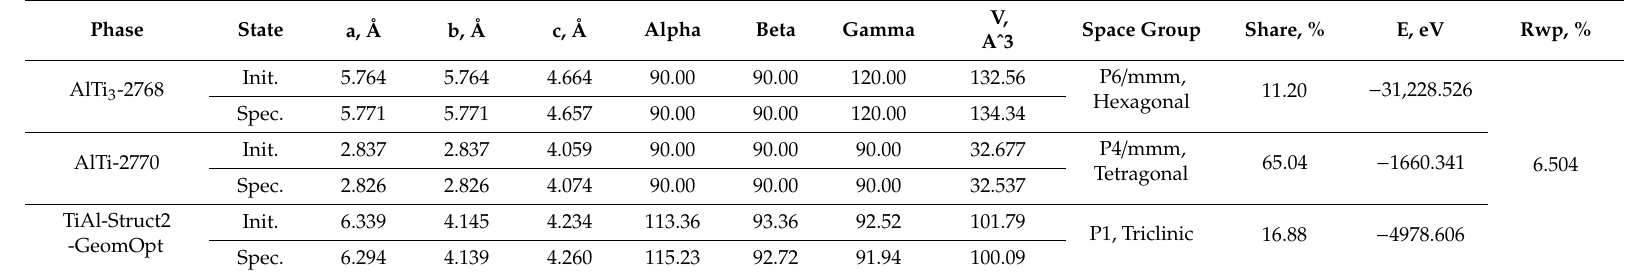
Table 4. Structural parameters of the lattices and the share of phases, and the convergence criterion of the TAD alloy.